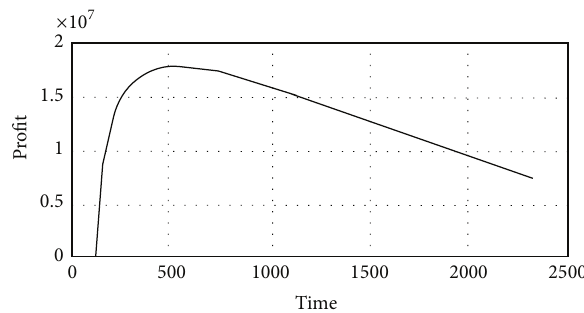
Figure 8: The dependence between the profit Pr 𝑜 and the number of products sold after which innovation is introduced